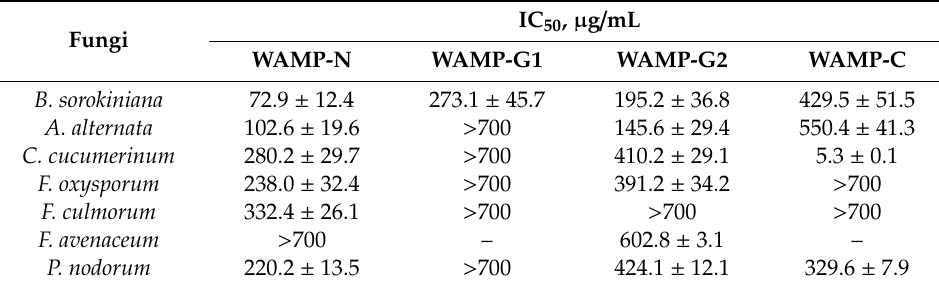
Table 3. Antifungal activity of WAMP-2-derived